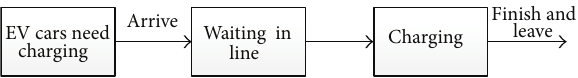
Figure 3: The diagram of EVs’ charging process.